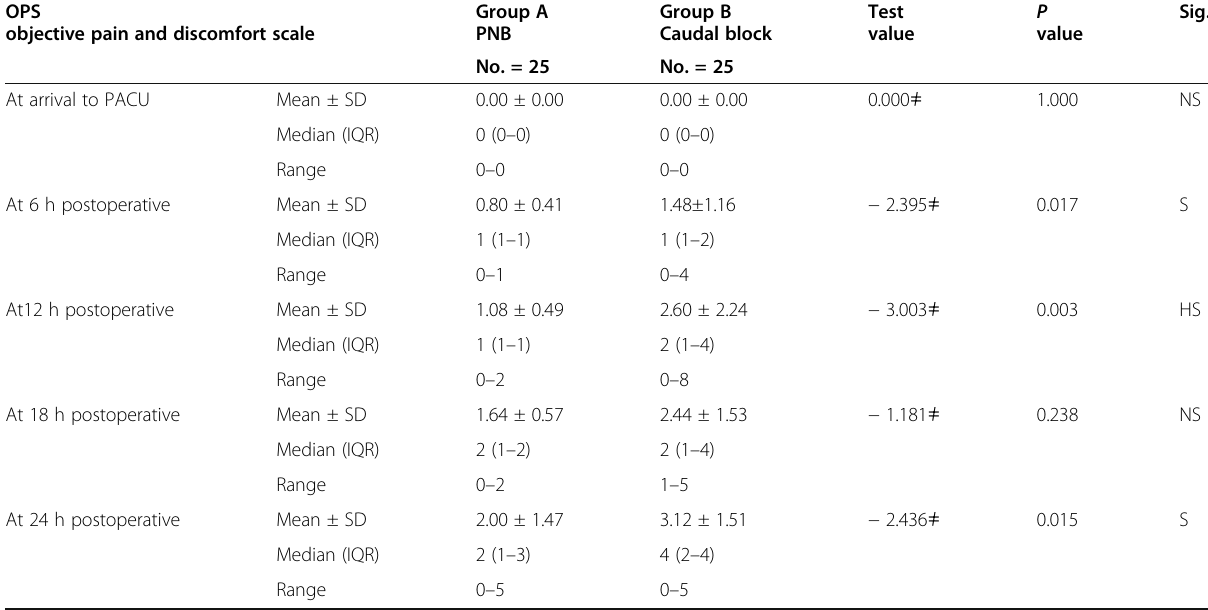
Table 3 Comparison between group A and group B regarding objective pain and discomfort scale (OPS) at different time of